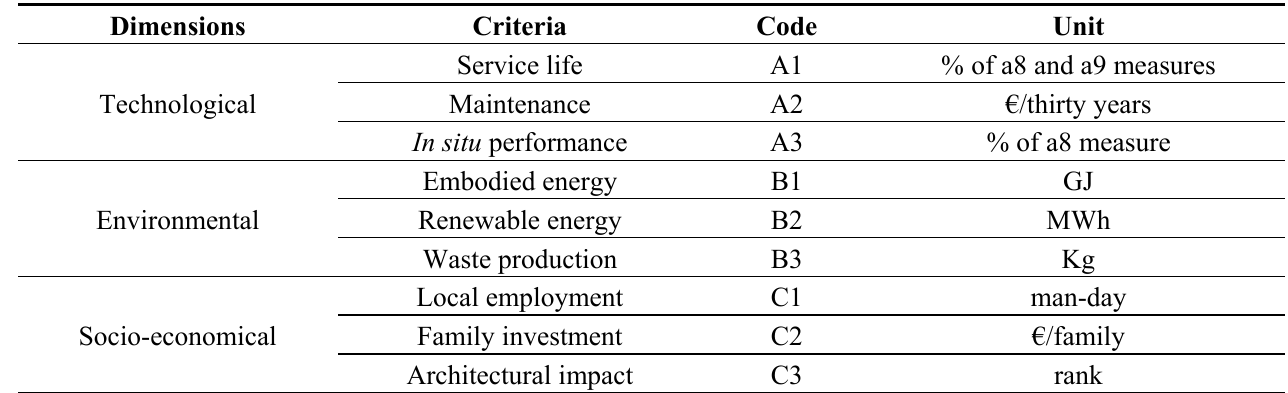
Table 5. Dimensions, criteria and evaluation scale